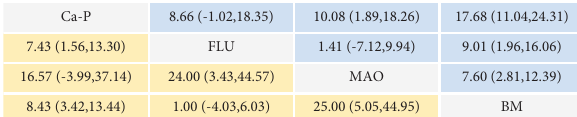
Figure 11: Mixture estimate confidence interval of different outcome assessments; yellow on the left represents the outcome of new bone, and the blue on the right represents the % degradation assessment.